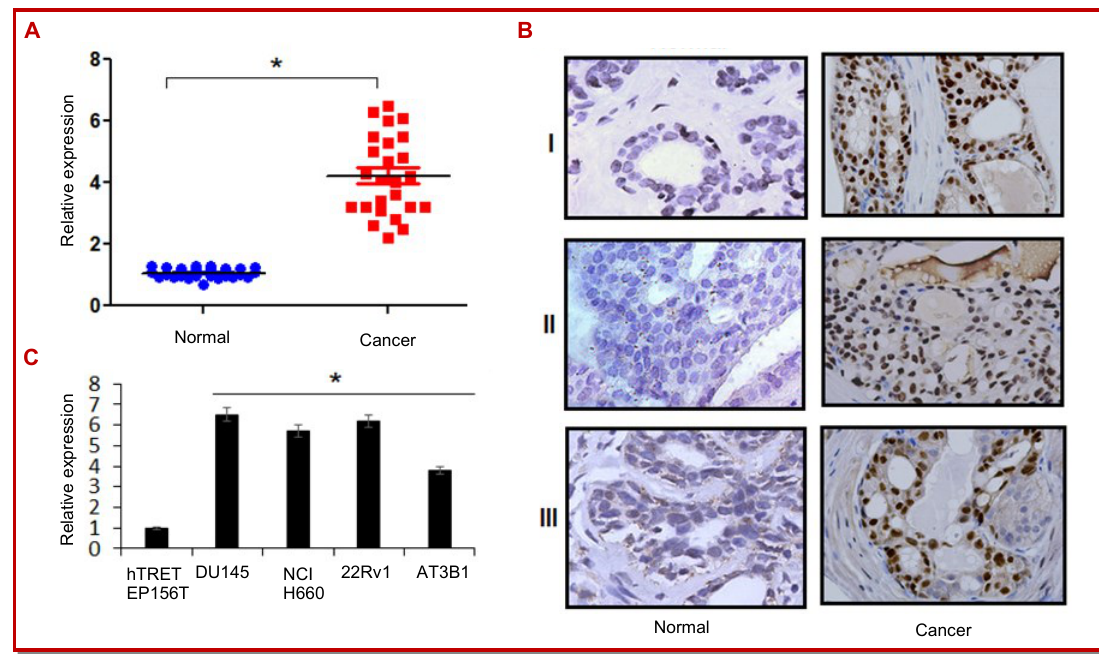
Figure 1: HOXC10 gene expression is upregulated in prostate cancer. (A) qRT-PCR expression analysis of HOXC10 gene in normal and cancerous tissue specimens; (B) IHC analysis showing expression of HOXC10 in prostate cancer and normal tissues; (C) ex- pression of HOXC10 in normal epithelial prostate cell line (hTERT EP156T) and the cancer cell lines (DU145, NCI-H660, 22Rv1 and AT3B1). The experiments were performed in triplicates and expressed as mean ± SD (*p< 0.05)